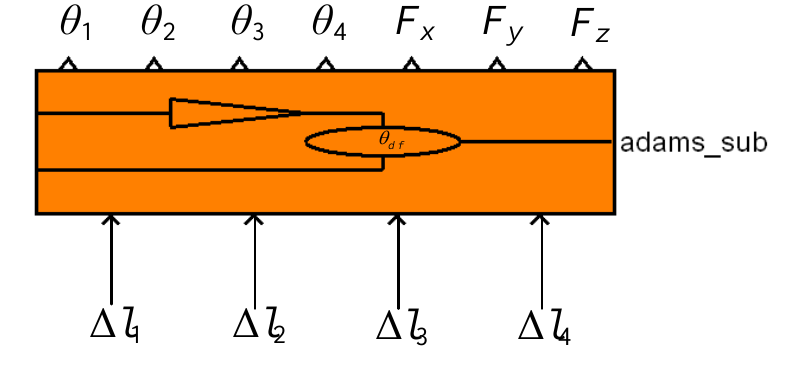
Figure 5. The control module of the three-DOF finger in